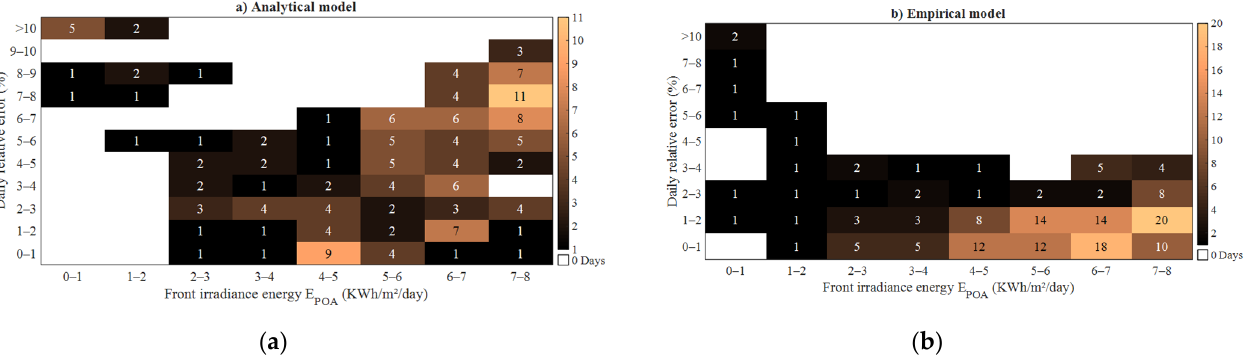
Figure 11. Heatmap of the daily errors of the analytical and the empirical models for monofacial modules. ( a ) Daily relative error distribution using the analytical model. ( b ) Daily relative error distribution using the empirical model.